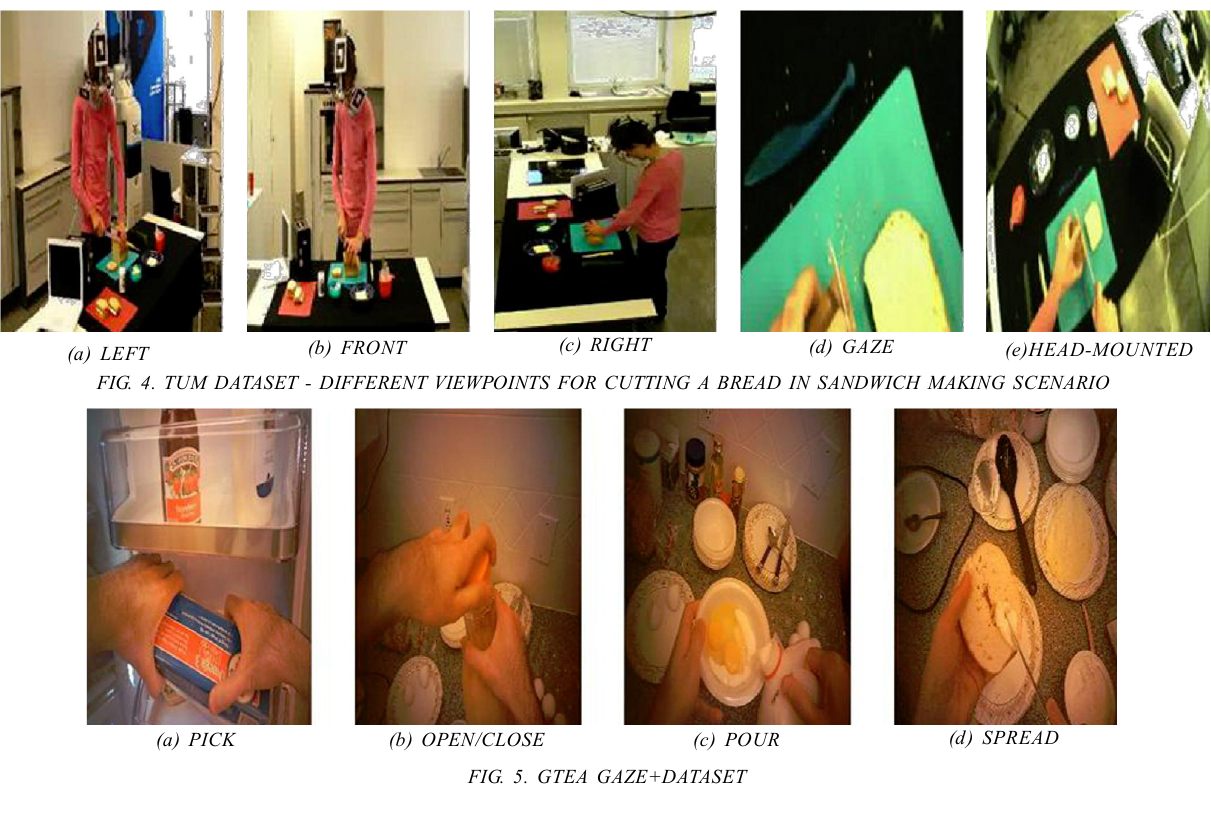
FIG. 4. TUM DATASET - DIFFERENT VIEWPOINTS FOR CUTTING A BREAD IN SANDWICH MAKING